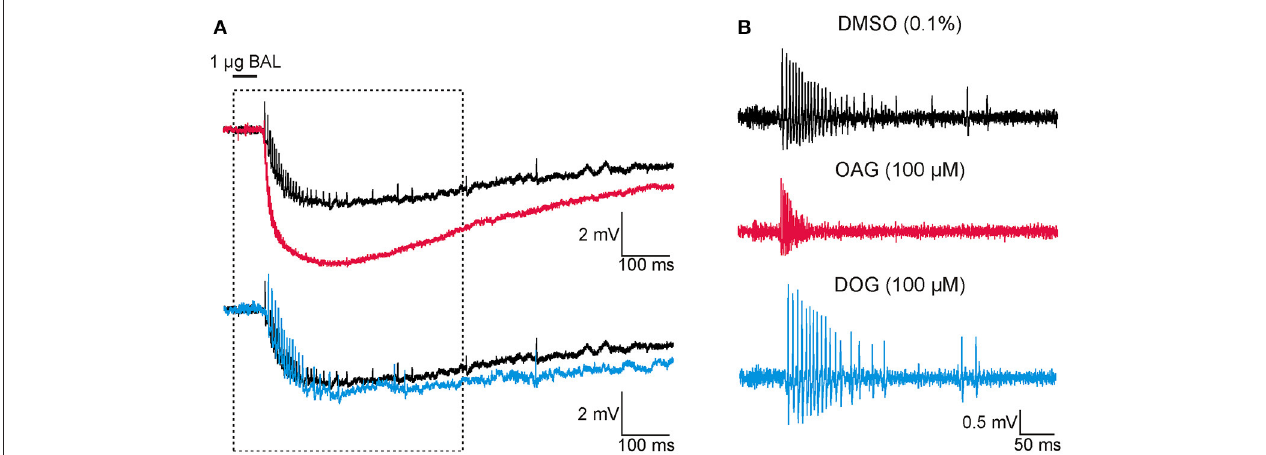
FIGURE 1 | At Zeitgeberzeit 1 (ZT 1) the diacylglycerol-analog OAG increased the response to bombykal (BAL, 1 µ g) while the diacylglycerol-analog DOG reduced it. Thus, both analogs target different DAG-dependent components of the BAL transduction cascade. Original tip-recordings from pheromone-sensitive trichoid sensilla on the antenna of the hawkmoth Manduca sexta show responses to 50ms pulses of BAL (1 µ g). Infusion of the DAG-analogs OAG (magenta, 100 µ M) or DOG (cyan, 100 µ M) via the tip-recording electrode were compared to control infusions with vehicle only (Ringer containing 0.1% DMSO, black) at the late activity phase at ZT 1. BAL-responses shown occurred about 30min after the beginning of the recordings. (A) Unfiltered recordings. Infusion of OAG (magenta), but not of DOG (cyan) accelerated and increased the pheromone-dependent sensillum potential amplitude and action potential response. In contrast, DOG rather slowed down the repolarization of the pheromone-response. Recordings in boxed area were enlarged in (B) . (B) High-pass filtered BAL responses illustrated that OAG (magenta) increased the frequency of the BAL-dependent action potential response and rendered it more phasic, as compared to the control (black). In contrast, DOG (cyan) slightly decreased and slowed down the